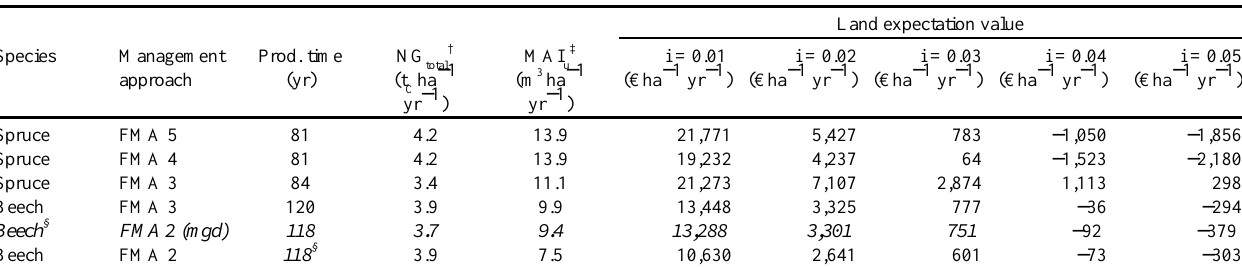
Table 4 . Productivity measures for the forest management alternatives, at the stand level.